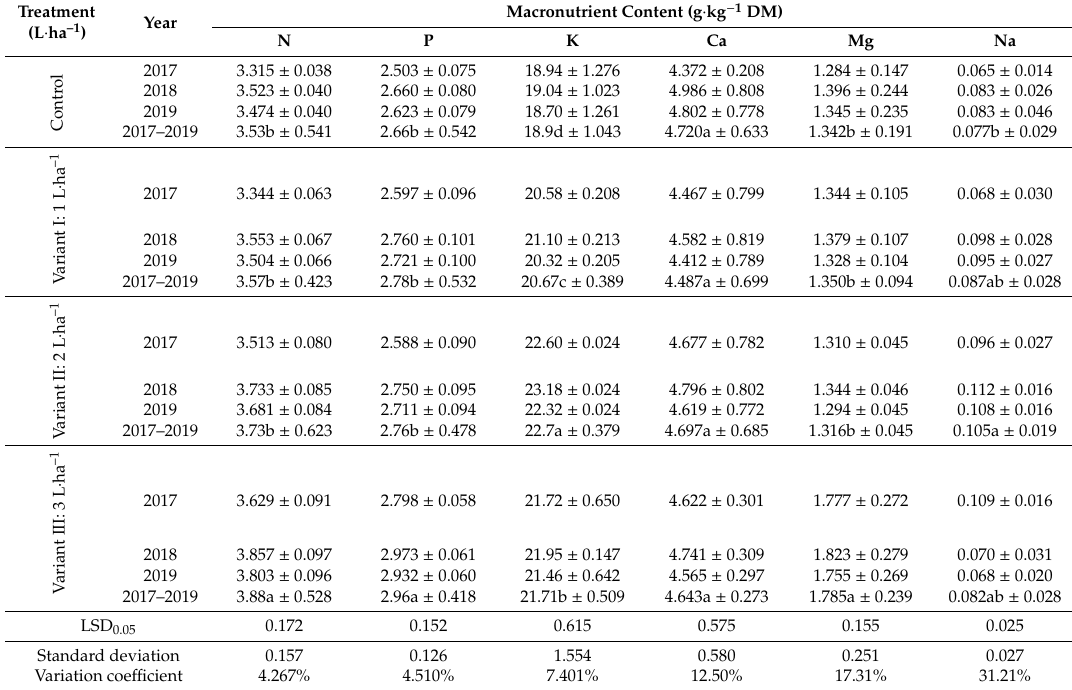
Table 5. The e ff ect of the amino acid stimulant on macronutrient content (g · kg − 1 DM) in plants of the lawn mixture (mean values + standard